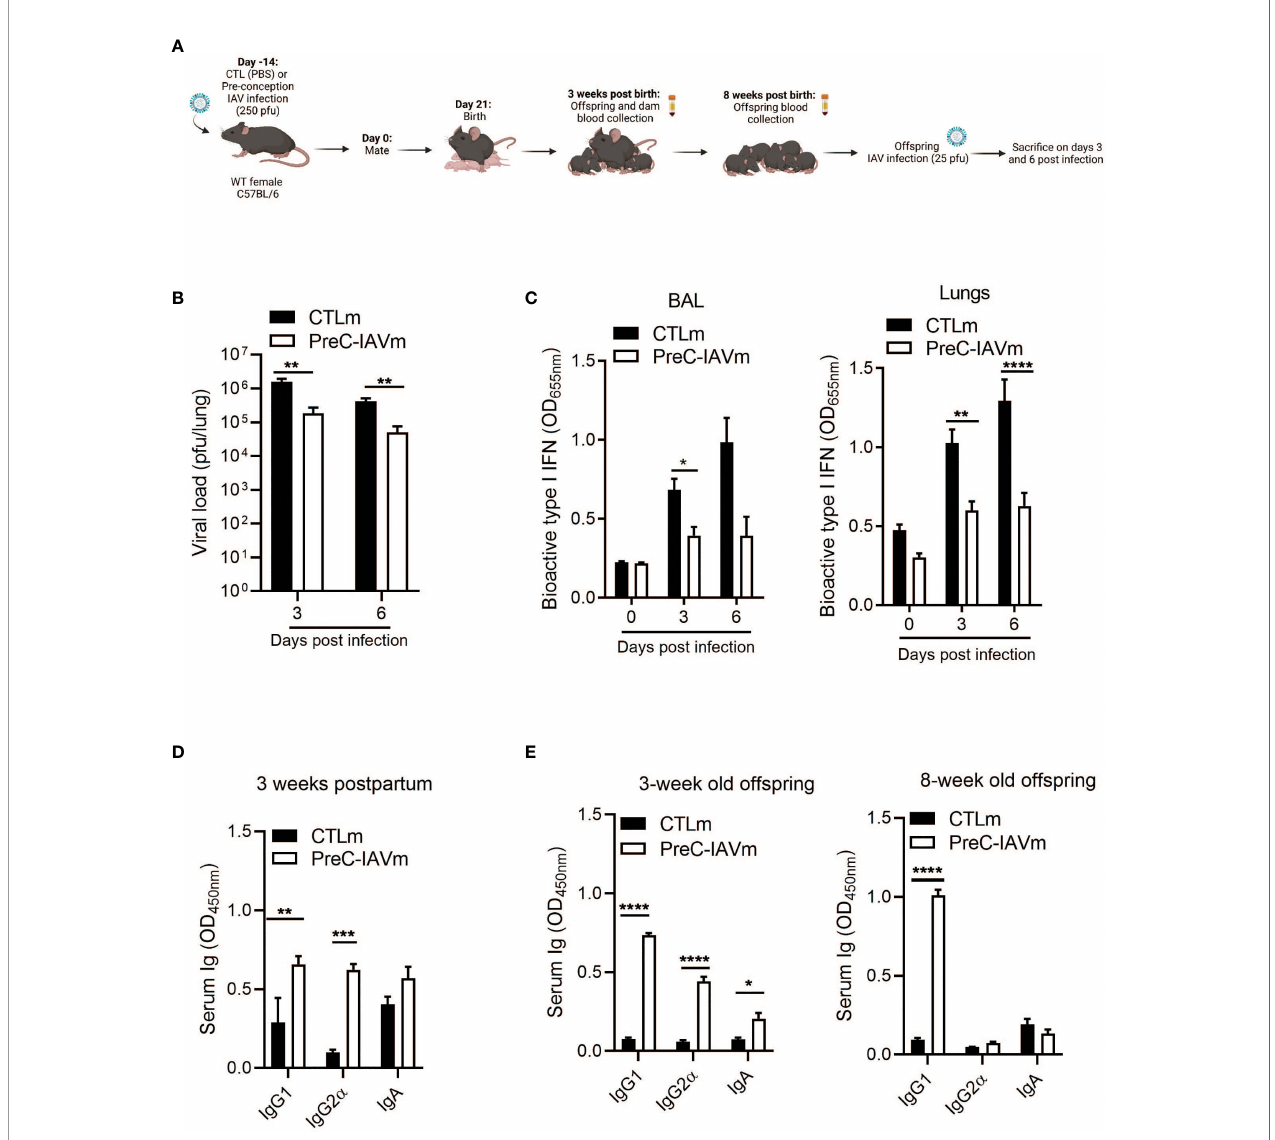
FIGURE 2 | Pre-conception IAV infection confers IgG1-speci fi c protection to offspring. (A) Schematic representation of experimental design. 8 – 10-week-old C57BL/6 females were given PBS (CTLm; n=3 dams) or infected with 250 pfu PR8 (PreC-IAVm; n=4 dams) intranasally two weeks prior to mating. Created with BioRender.com (B) Kinetics of viral load in whole lung homogenates by MDCK assay (n=3-4 offspring) and (C) type I IFNs in BALF and lungs by B16 assay of 8-week-old offspring born to control or PreC-IAV dams infected with 25 pfu PR8 (n=4-10 offspring). Multiple Student T-tests with Bonferroni correction for multiple comparisons were performed on BALF on day 0 and day 3 *p<0.05. No statistical analysis was performed on day 6 (CTLm n=2). (D) Serum antibody levels of control and PreC-IAVm dams 3 weeks postpartum (n=3-4). (E) Serum antibody levels of naïve offspring at 3 weeks and 8 weeks of age prior to secondary infection (n=3-7 offspring). Data pooled for male and female offspring. Two-way ANOVA *p < 0.05, **p < 0.01, ***p < 0.001, ****p < 0.0001. License acquired for schematics from